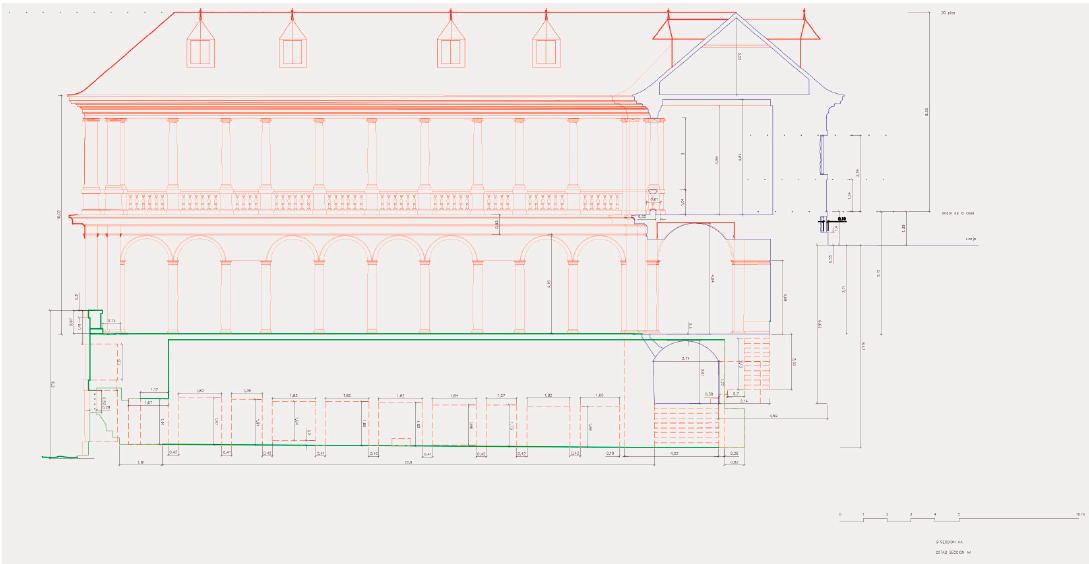
Figure 17. Pilar Chías and Tomás Abad, 2017: Section drawing of the complex of the Botica and Galería de Convalecientes . Original scale 1:50. Blue lines correspond to the cross section showing the upper cellar of the Galería, while green lines depict the longitudinal section of the lower cellar.